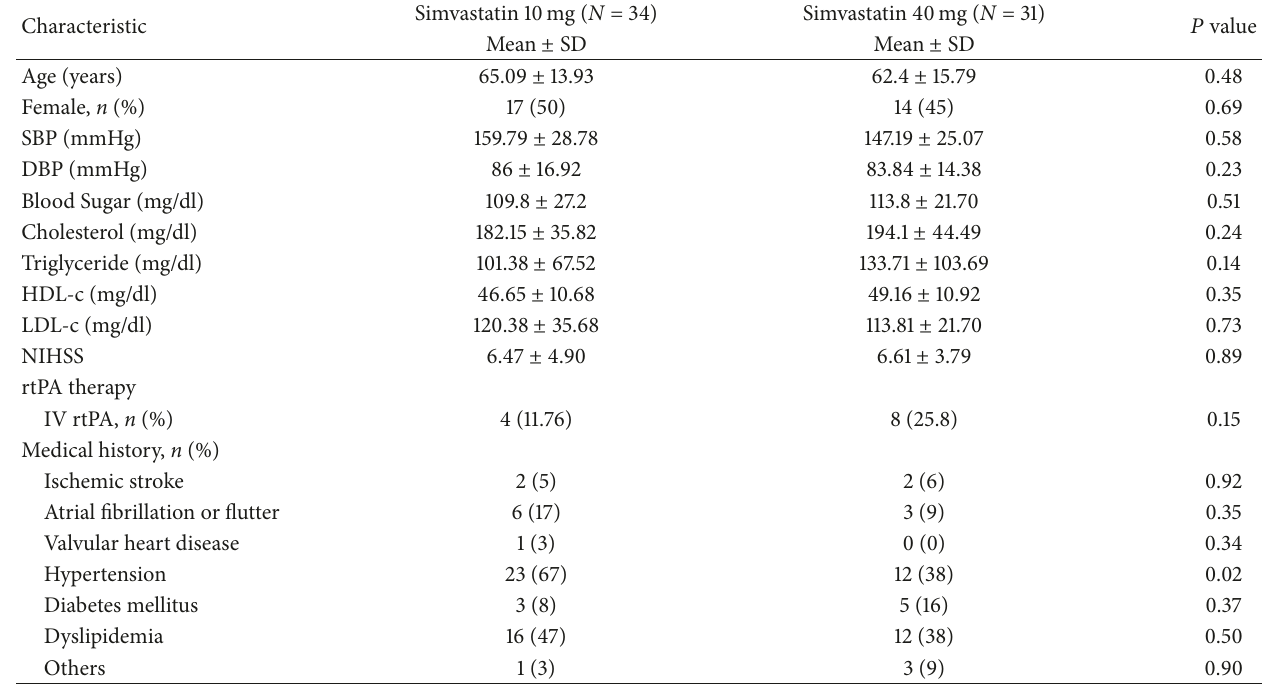
Table 1: Baseline characteristics of patients with acute ischemic stroke receiving simvastatin therapy.